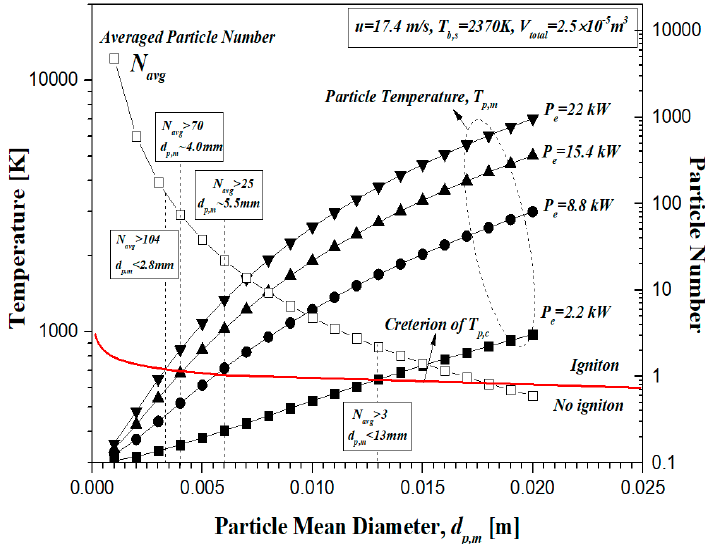
Figure 13. The effects of particle temperature and particle number on the particle mean diameter for Pe = 2.2 kW, 8.8 kW, 15.4 kW and 22 kW.